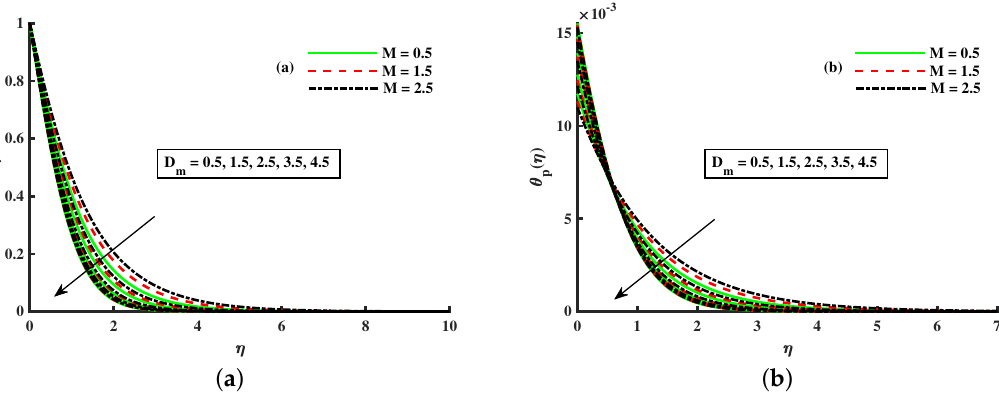
Figure 4. Fluctuation of M and D m on θ ( η ) ( a ) and the effect of M and D m on θ p ( η ) ( b ).